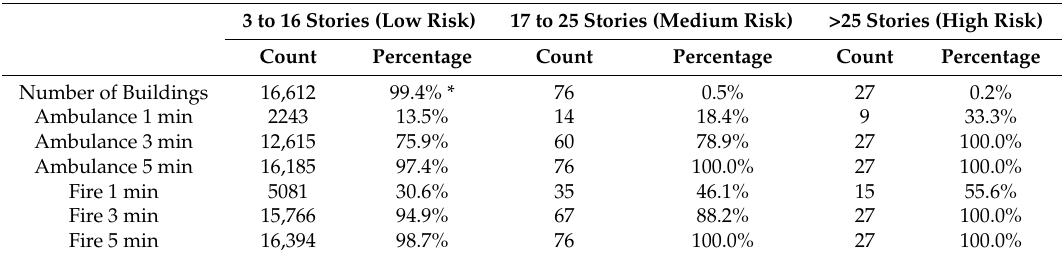
Table 2. Toronto high-rise buildings by story classification and first responder service